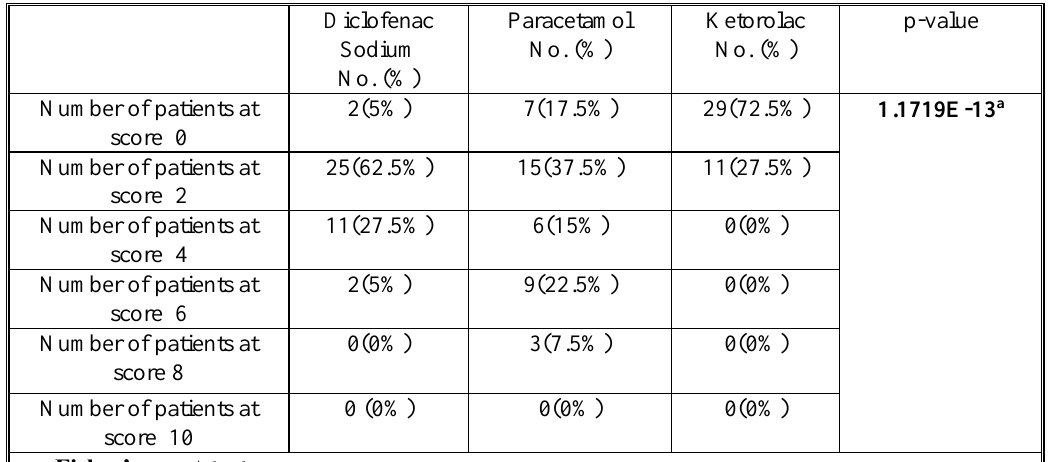
Figure 1. Percent of the frequency of pain score for the study groups after 30 minutes of surgery. Note: There are (0%) at score 10 of all three groups, Table 3. Pain score after 60 minutes of surgery for the study